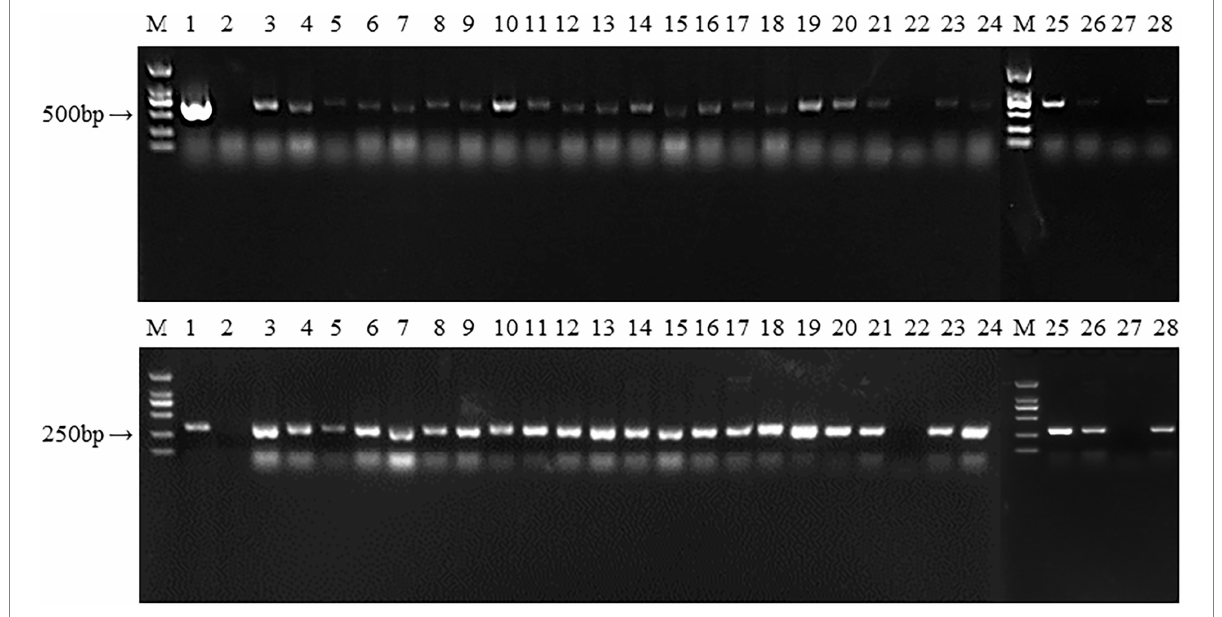
FIGURE 7 The PCR identification of transformants. M: DL 2000; 1: Plasmid as positive control; 2: untransformed strain L087 as negative control; 3–24: Transformants; M: DL 2000; 25–28: